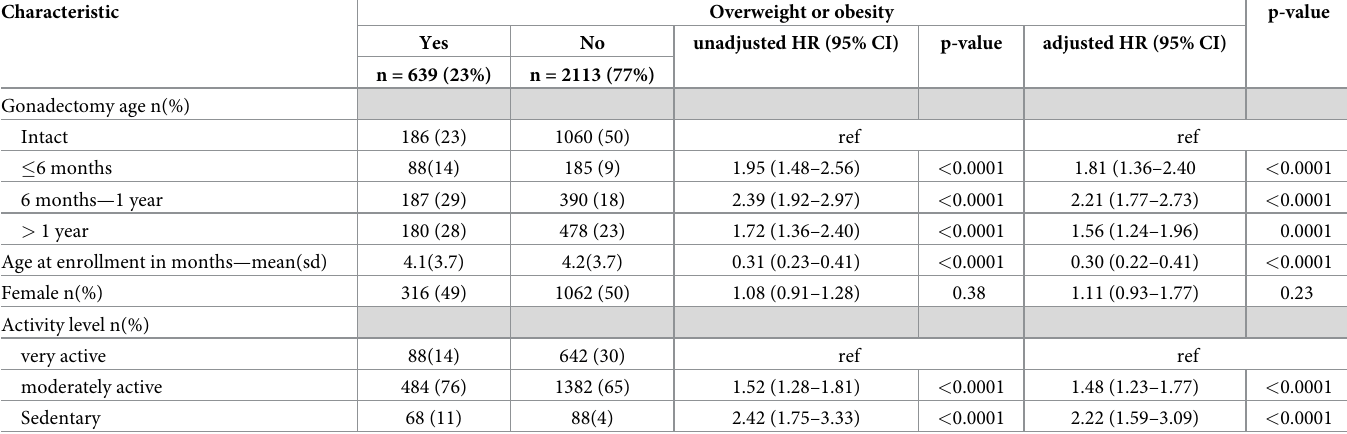
Table 1. Descriptive characteristics, unadjusted, and adjusted hazard ratios for the risk for overweight/obesity in a cohort of Golden Retrievers as a function of gonadectomy.